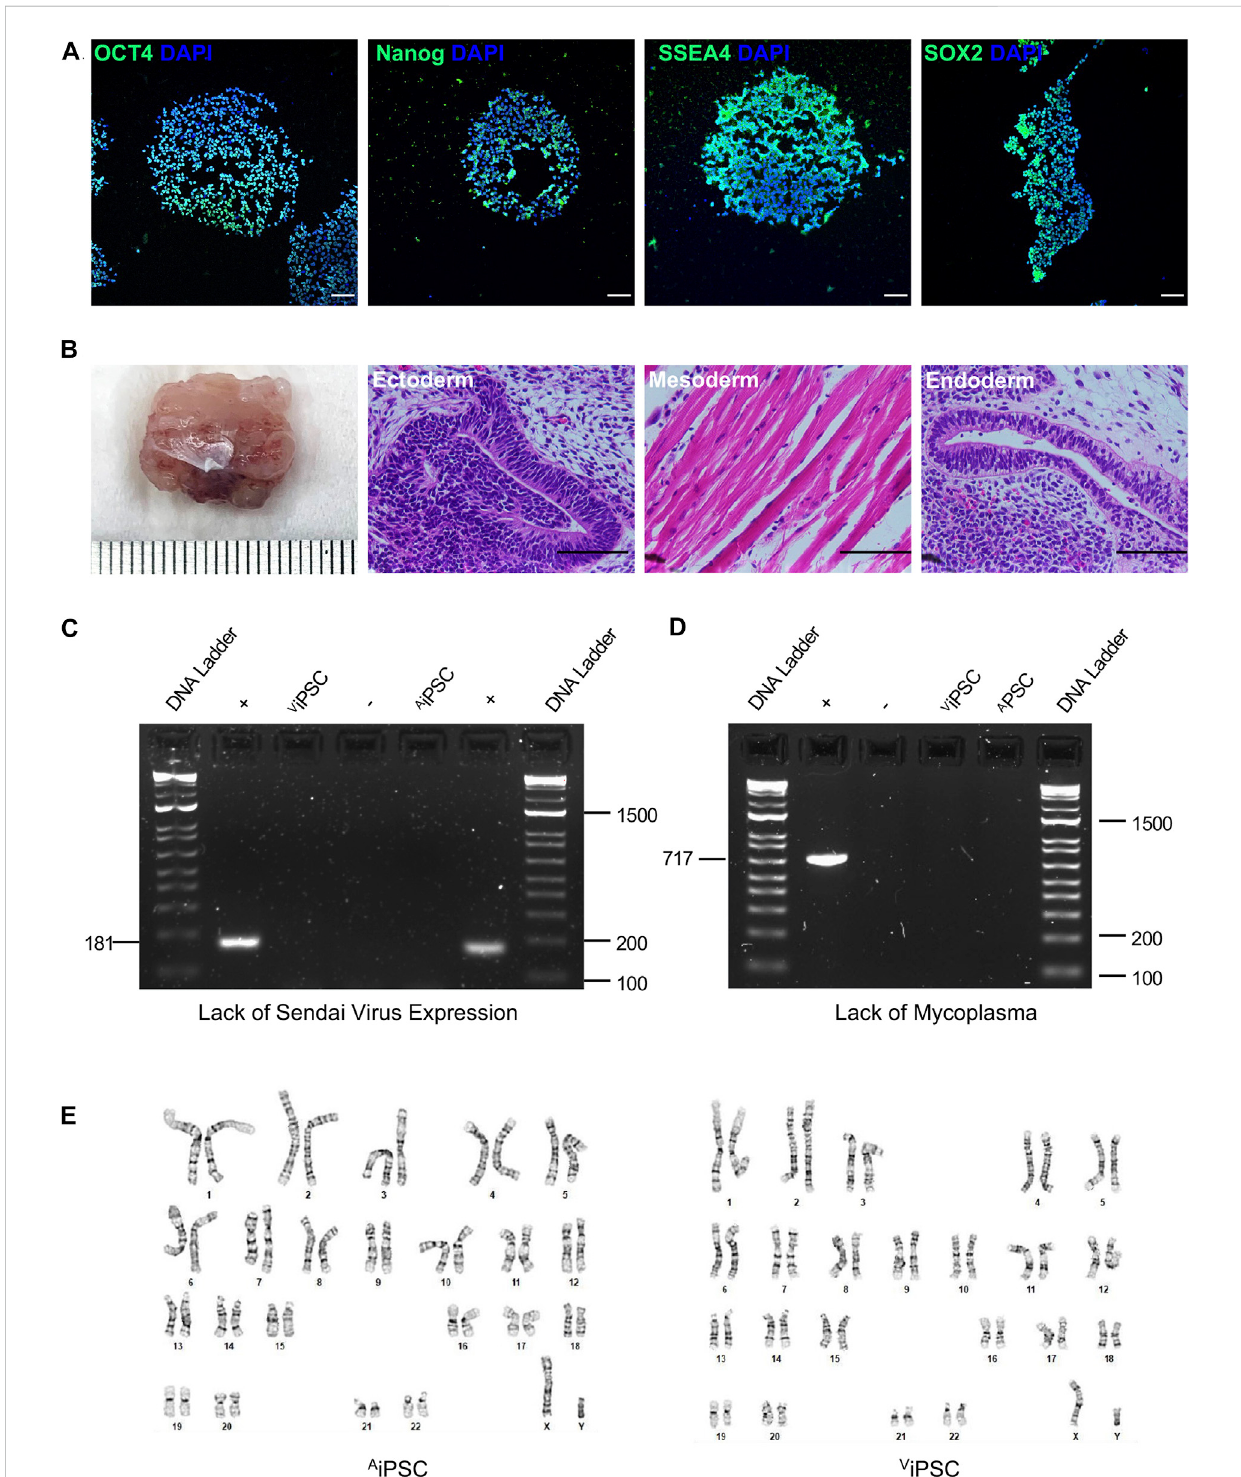
FIGURE 2 A iPSC and V iPSC were pluripotent with normal karyotypes. (A) Expression of the pluripotency markers OCT4, Nanog, SSEA4, and Sox2 was evaluated via immuno fl uorescence staining in A iPSC and V iPSC. Nuclei were counterstained with DAPI (representative images of V iPSC; bar = 100 μ m) (B) A iPSC and V iPSC were subcutaneously transplanted into immunode fi cient mice and grew to form teratomas over the ensuing 8 weeks; then, the teratoma was excised,sectioned,stainedwithhematoxylinandeosin,andexaminedforthepresenceofallthreedevelopmentalgermlayers:ectoderm(i.e.,neural epithelium),mesoderm(i.e.,striatedmuscle),andendoderm(i.e.,gut-likeepithelium)(representativeimagesfor V iPSCteratomas;bar=100 μ m). (C) Loss of the Sendai virus vector was con fi rmed by electrophoresis of RT-PCR products at passage 10. (D) The absence of mycoplasma contamination